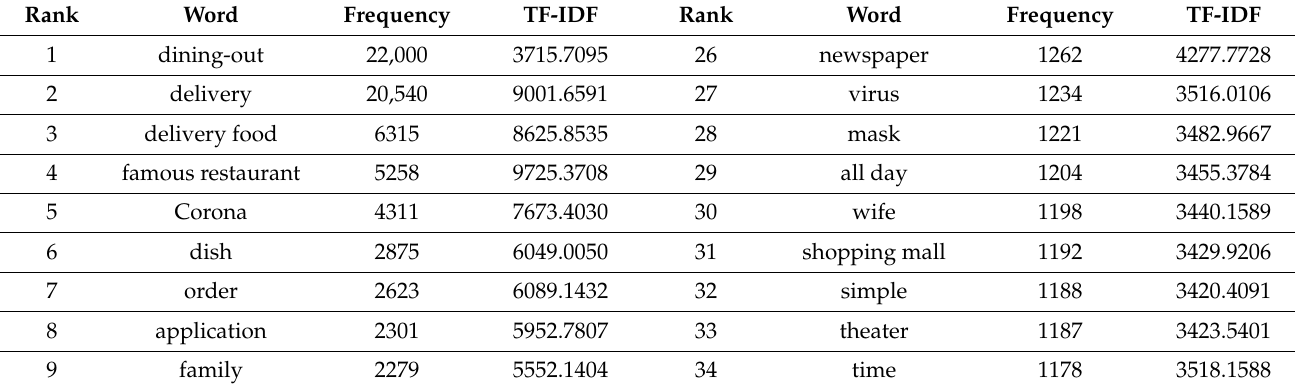
Table 4. Text mining of food delivery